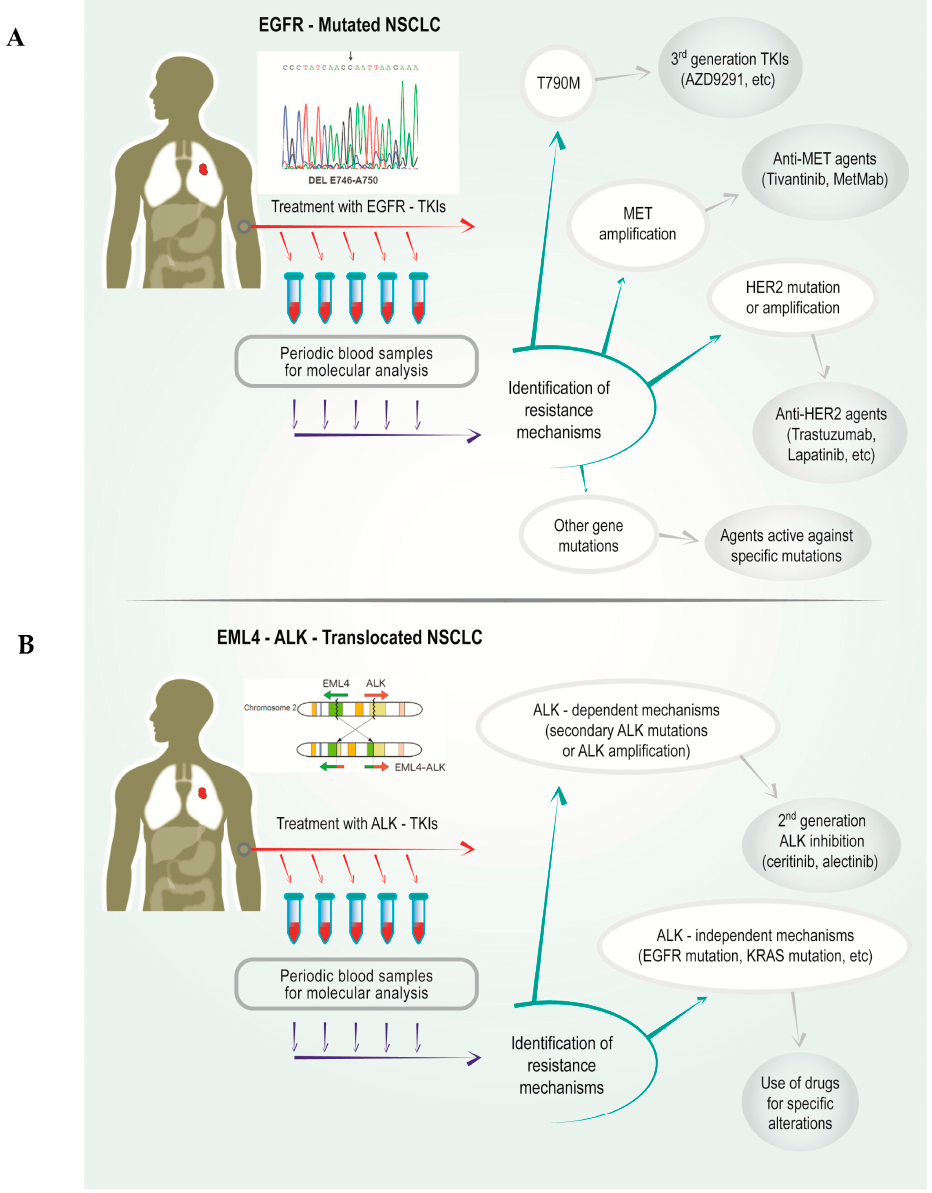
Figure 1. Schematic representation of the possible impact of liquid biopsy analysis during the course of treatment in ( A ) an epidermal growth factor receptor ( EGFR )-mutated patient treated with an EGFR- tyrosine kinase inhibitors (TKIs) and ( B ) a patient with echinoderm microtubule associated protein like 4–anaplastic lymphoma kinase ( EML4–ALK ) translocation treated with an ALK-TKI. NSCLC, non-small-cell lung cancer; MET, mesenchymal–epithelial transition; HER2, human epidermal growth factor receptor 2.